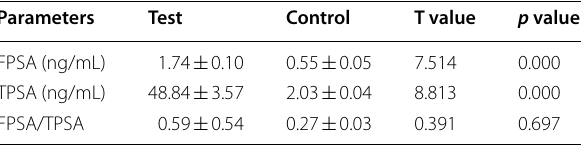
This table shows serum marker of prostate cancer among prostate cancer patients. Values are Mean Standard error of mean, and statistically significant ± difference was set at p < 0.05